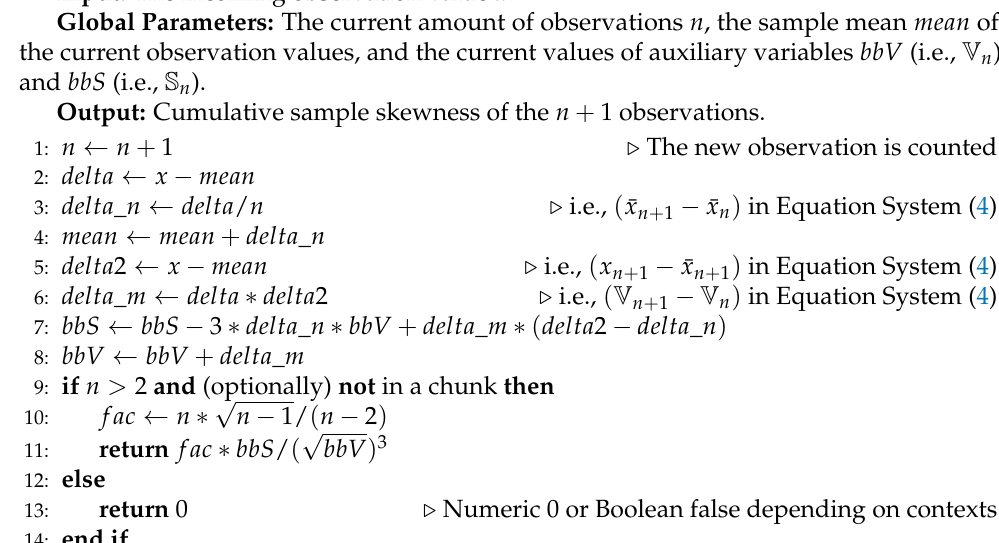
Algorithm 3 Cumulative Sample Skewness in this